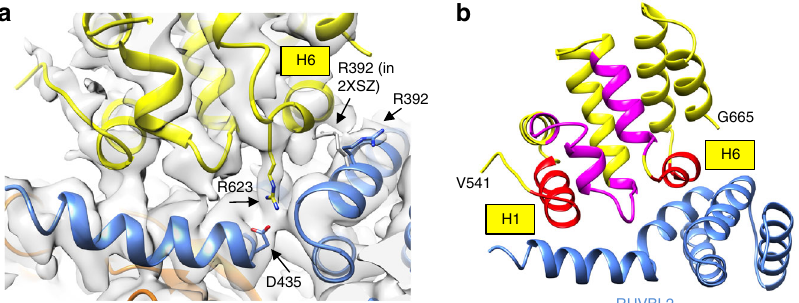
Fig. 6 Structural details of RUVBL1 – RUVBL2 – RBD. a R392 residue in RUVBL2 of the RUVBL1 – RUVBL2 – RBD complex (model in blue color within the density) shows a different conformation to its position in the crystal structure of RUVBL1 – RUVBL2 (structure in gray color) (PDB 2XSZ) 29 . R623 in RBD is also visible and pointing toward RUVBL2. b Helix 1 and 6 are 100% identical in those species analyzed (red color). Other regions shown in magenta color also revealed